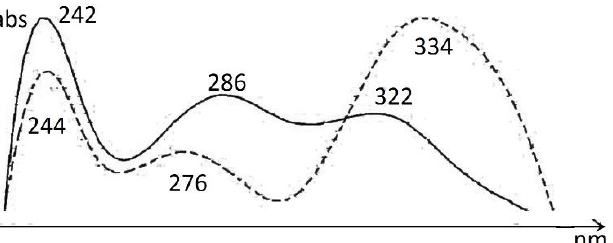
Figure 5. Spectra revealing the difference in UV-absorbance of α - (continuous) and β - (dotted) bitter acids in hops.